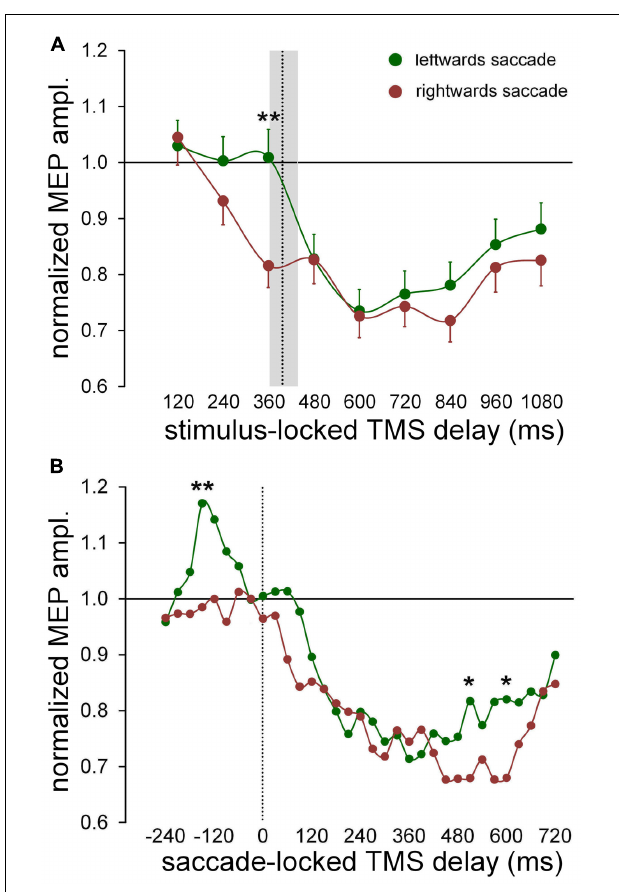
FIGURE 4 | Changes of excitability in FDI muscle as a function of saccade direction. Data points were computed by averaging normalized MEP amplitudes across subjects irrespective of type of the oculomotor response (pro-/anti-saccade). Continuous lines represent a spline interpolation of the data. (A) Mean values were computed as a function of TMS delay with respect of the onset of the visual stimulus (‘stimulus-locked TMS delay’). The vertical dotted line depicts the median value of saccade latencies and the grey shade indicates the interquartile range. Error bars represent the standard errors of the mean. (B) Data points represent a moving average computed every 30 ms, on saccade-locked TMS delays falling within a range of ± 60 ms around the plotted value. Vertical dotted line marks the saccade onset. ∗ and ∗∗ denote a statistically significant difference between leftward and rightward saccades with p < 0.05 and p < 0.01 (type II Wald χ 2 tests),